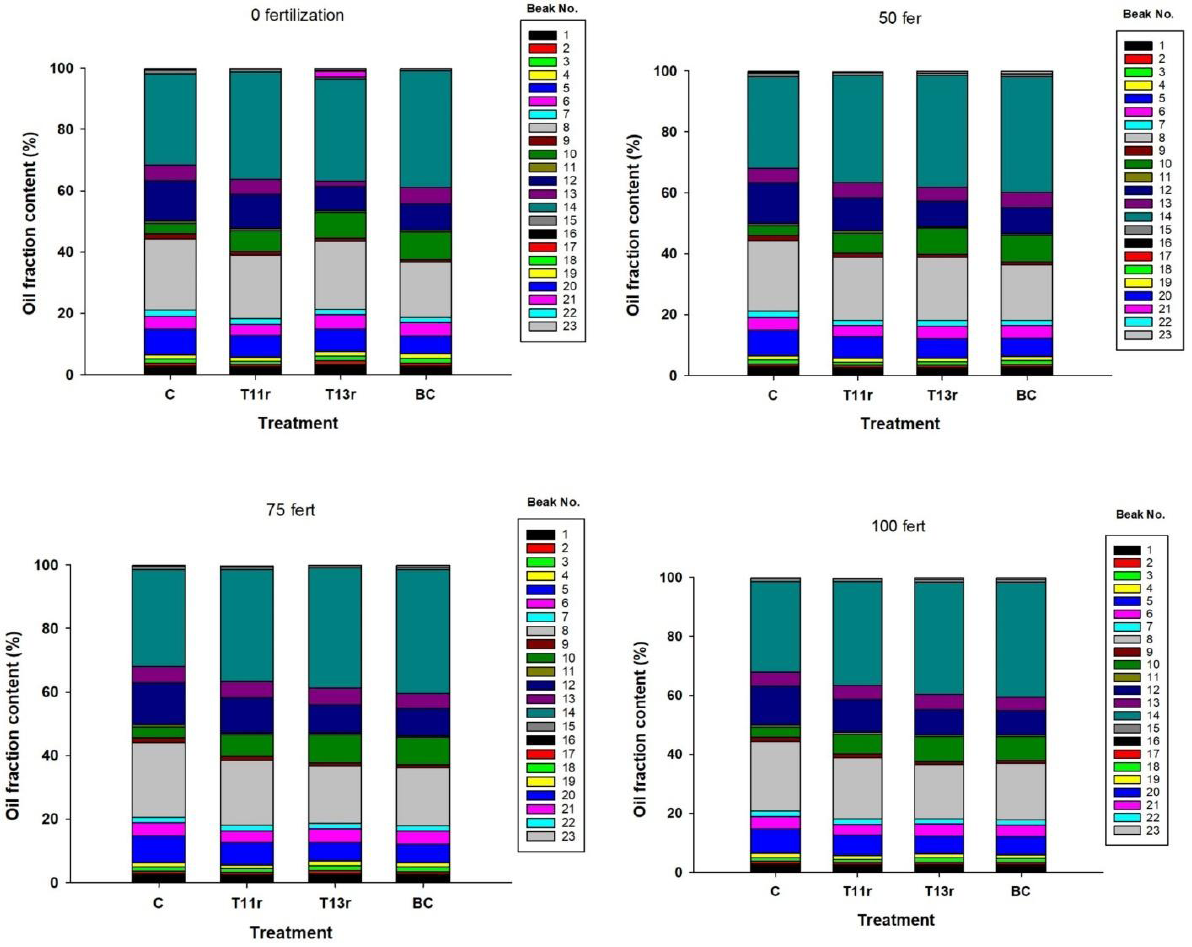
Figure 5: Percentages of oil fractions based on GC-MS analysis in the presence and absence of mineral fertilization (0, 50, 75, and 100%) and bacterial inoculation. C is a control (presence of mineral fertilization and absence of endophytic bacteria; T11r is B. licheniformins ; T13r is B. velezensis; BC is an endophytic bacterial consortium (T11r+T13r). The description of each peak number is listed in Table